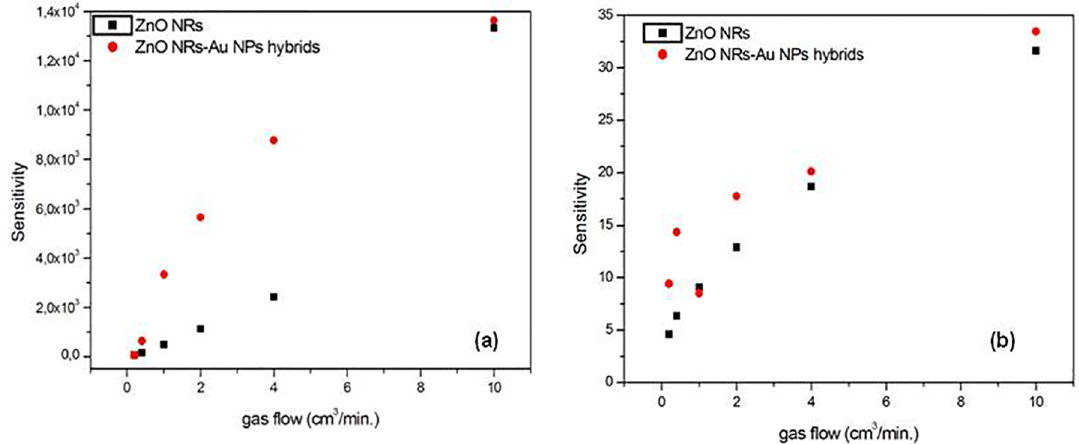
gas flow and (b) O 2